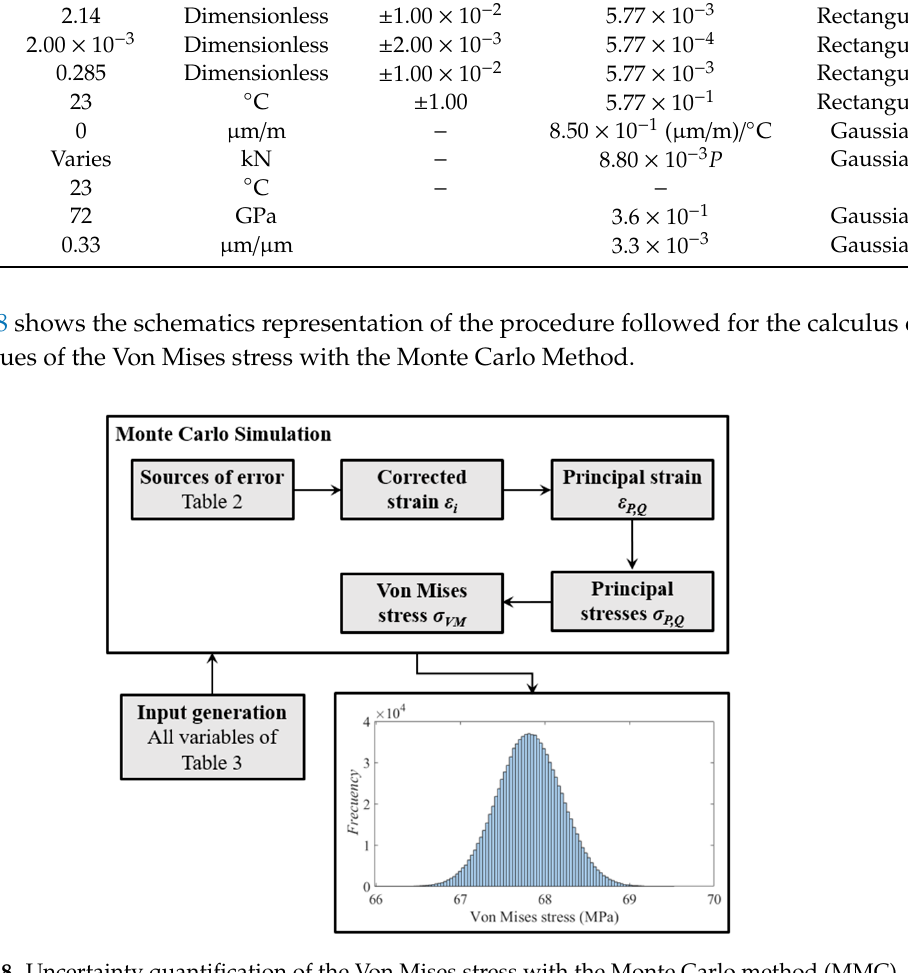
Figure 8. Uncertainty quantification of the Von Mises stress with the Monte Carlo method (MMC).